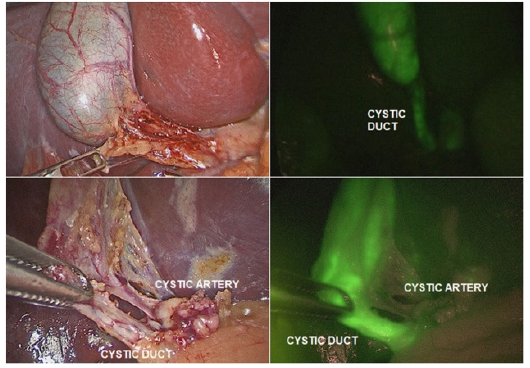
Figure 2. From Esposito et al. (2020) [10]. Indocyanine green (ICG)-guided near-infrared fluorescence (NIRF) identifying the cystic duct and artery.